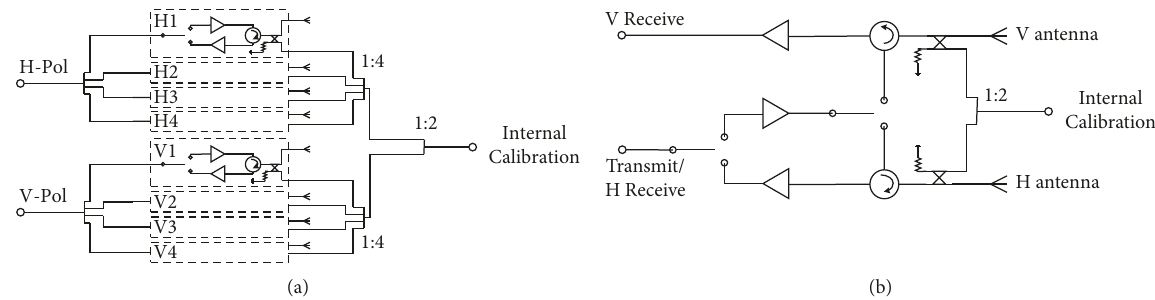
Figure 1: Schematic diagram of RF chains schemes. (a) Isolated H/V T/R chains. (b) Shared H/V T/R